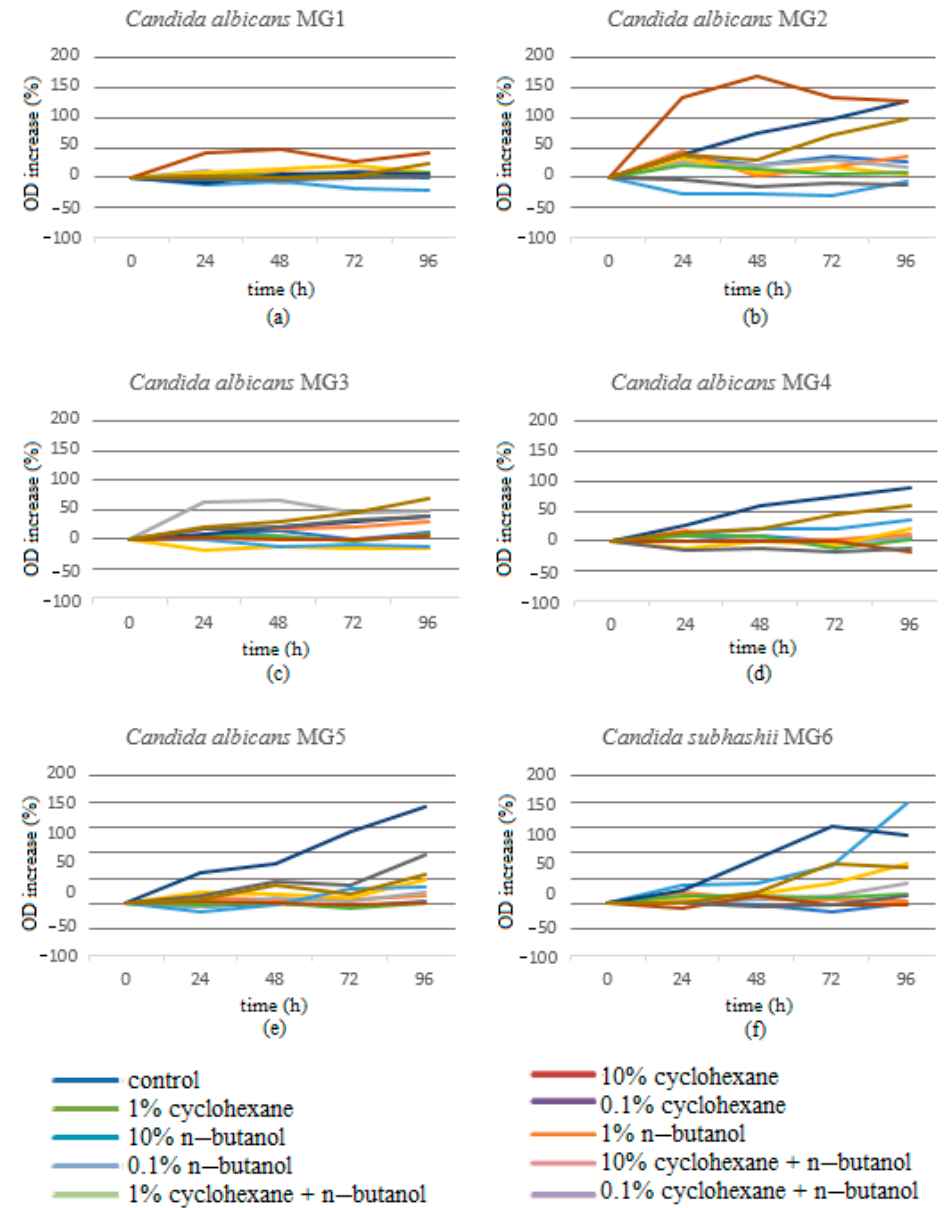
Figure 3. The growth curves of examined strains cultured in the presence of cyclohexane, n -butanol and their selected mixtures. ( a ) Candida albicans MG1. ( b ) Candida albicans MG2. ( c ) Candida albicans MG3. ( d ) Candida albicans MG4. ( e ) Candida albicans MG5. ( f ) Candida subhashii MG6. OD—optical density.